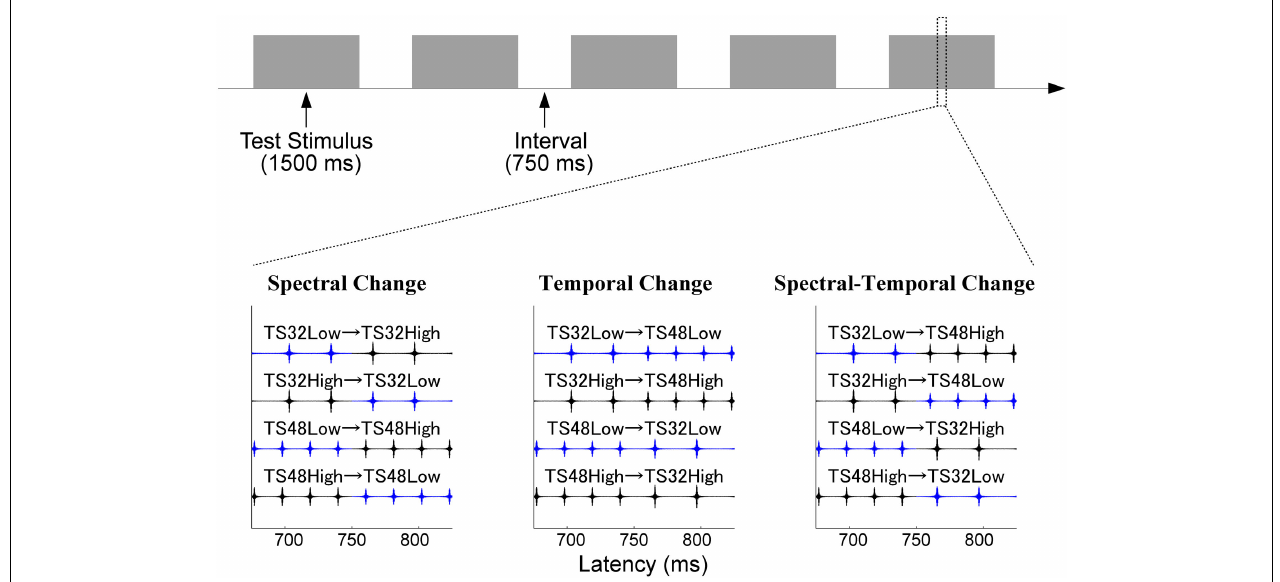
FIGURE 2 | Experimental procedure in experiment 2. The figure displays the sound waveforms of the test stimuli (band-pass filtered train pulses) arranged according to Figure 1 . Blue and black lines represent low and high band-pass filtered